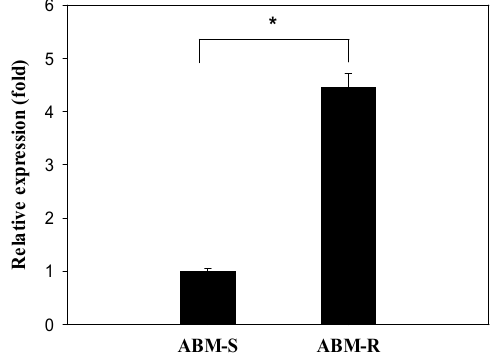
2 is Chi square and df is degree of freedom. 50 of ABM-S; X